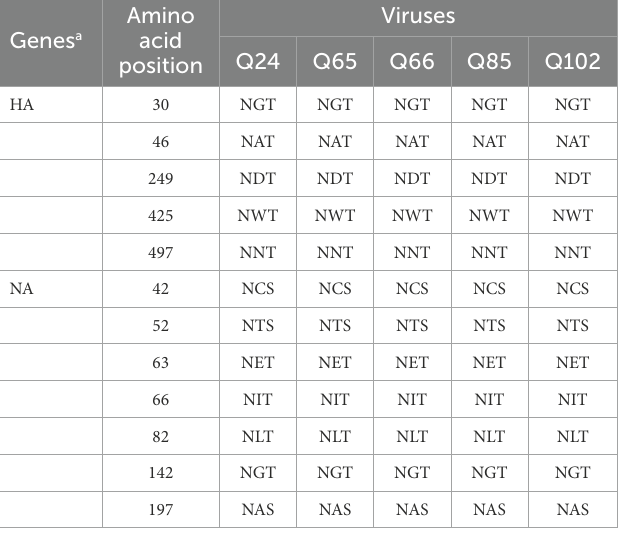
TABLE 3 Summary of the potential glycosylation sites in HA and NA genes of the Q24, Q65, Q66, Q85, and Q102 viruses. Amino Genes a acid